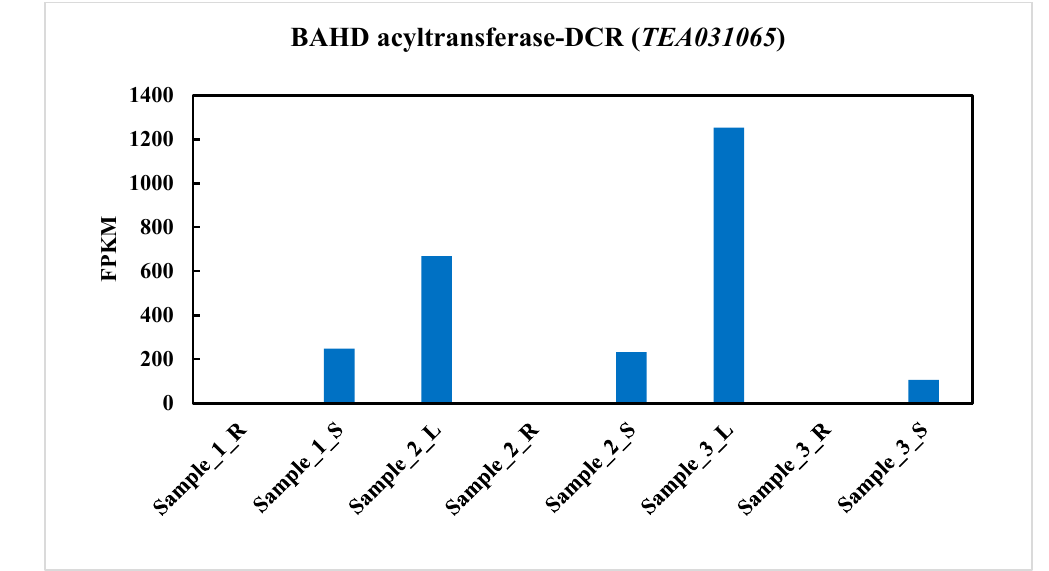
Figure 2. Expression level of BAHD acyltransferase ( TEA031065 ) gene in three different tissues (root, stem, and leaf) in tea plant ( C. sinensis ). The eight samples were divided into three groups: 1-R, newly growing root; 1-S, newly growing shoot; 2-L, second-stage leaf; 2-R, second-stage root; 2-S, second-stage stem; 3-L, third-stage leaf; 3-R, third-stage root; 3-S, third-stage stem. The means of RNA-seq. analysis data are the ± SD ( n = 1) p ˂ 0.05.